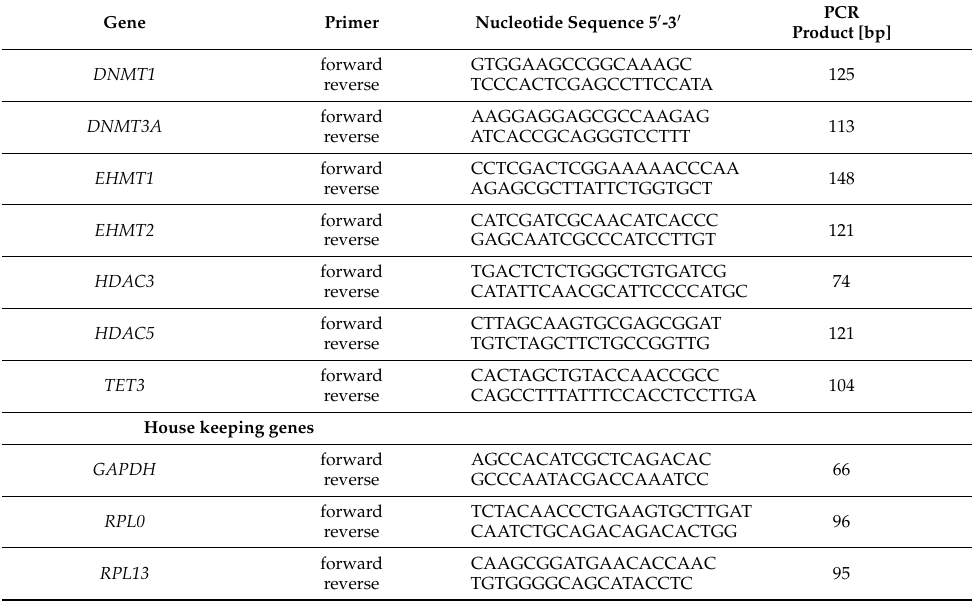
Table 1. The primers’ sequences used in the Real-Time